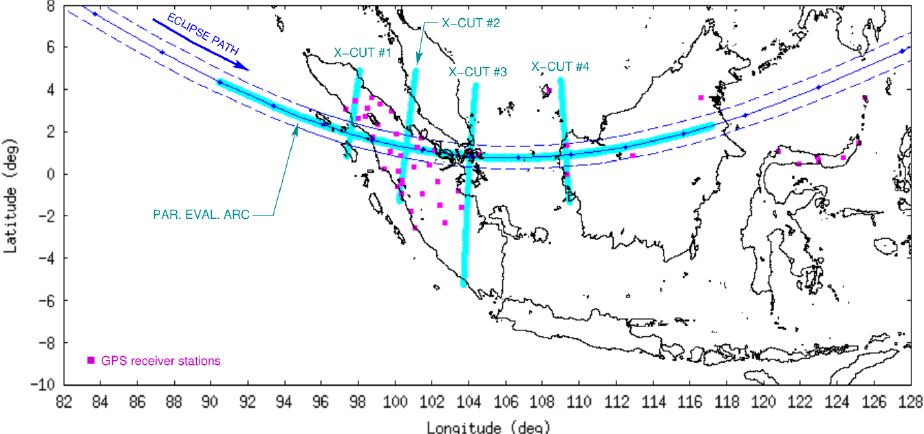
Figure 11. Geographical map showing a set of cut lines, along and perpendicular to the solar-eclipse path, for an extended analysis of TEC variation in response to the eclipse. The cut line along the eclipse path is referred to as the parallel evaluation arc , and those perpendicular to the eclipse path are referred to as x-cut nos. 1 to